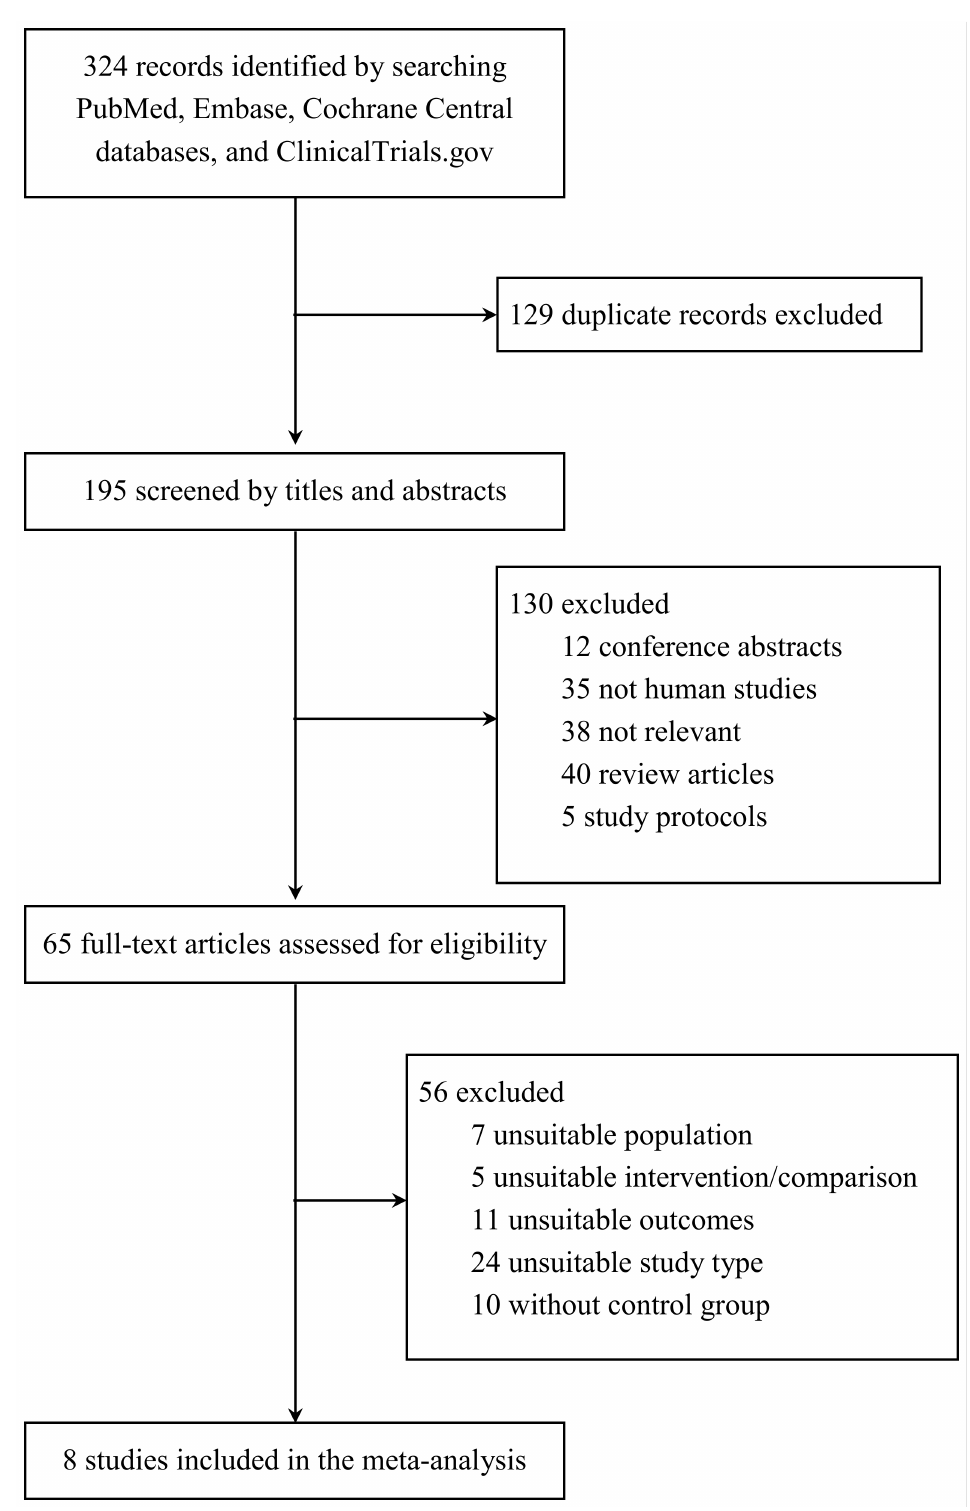
Figure 1. Flowchart of the literature search and trial